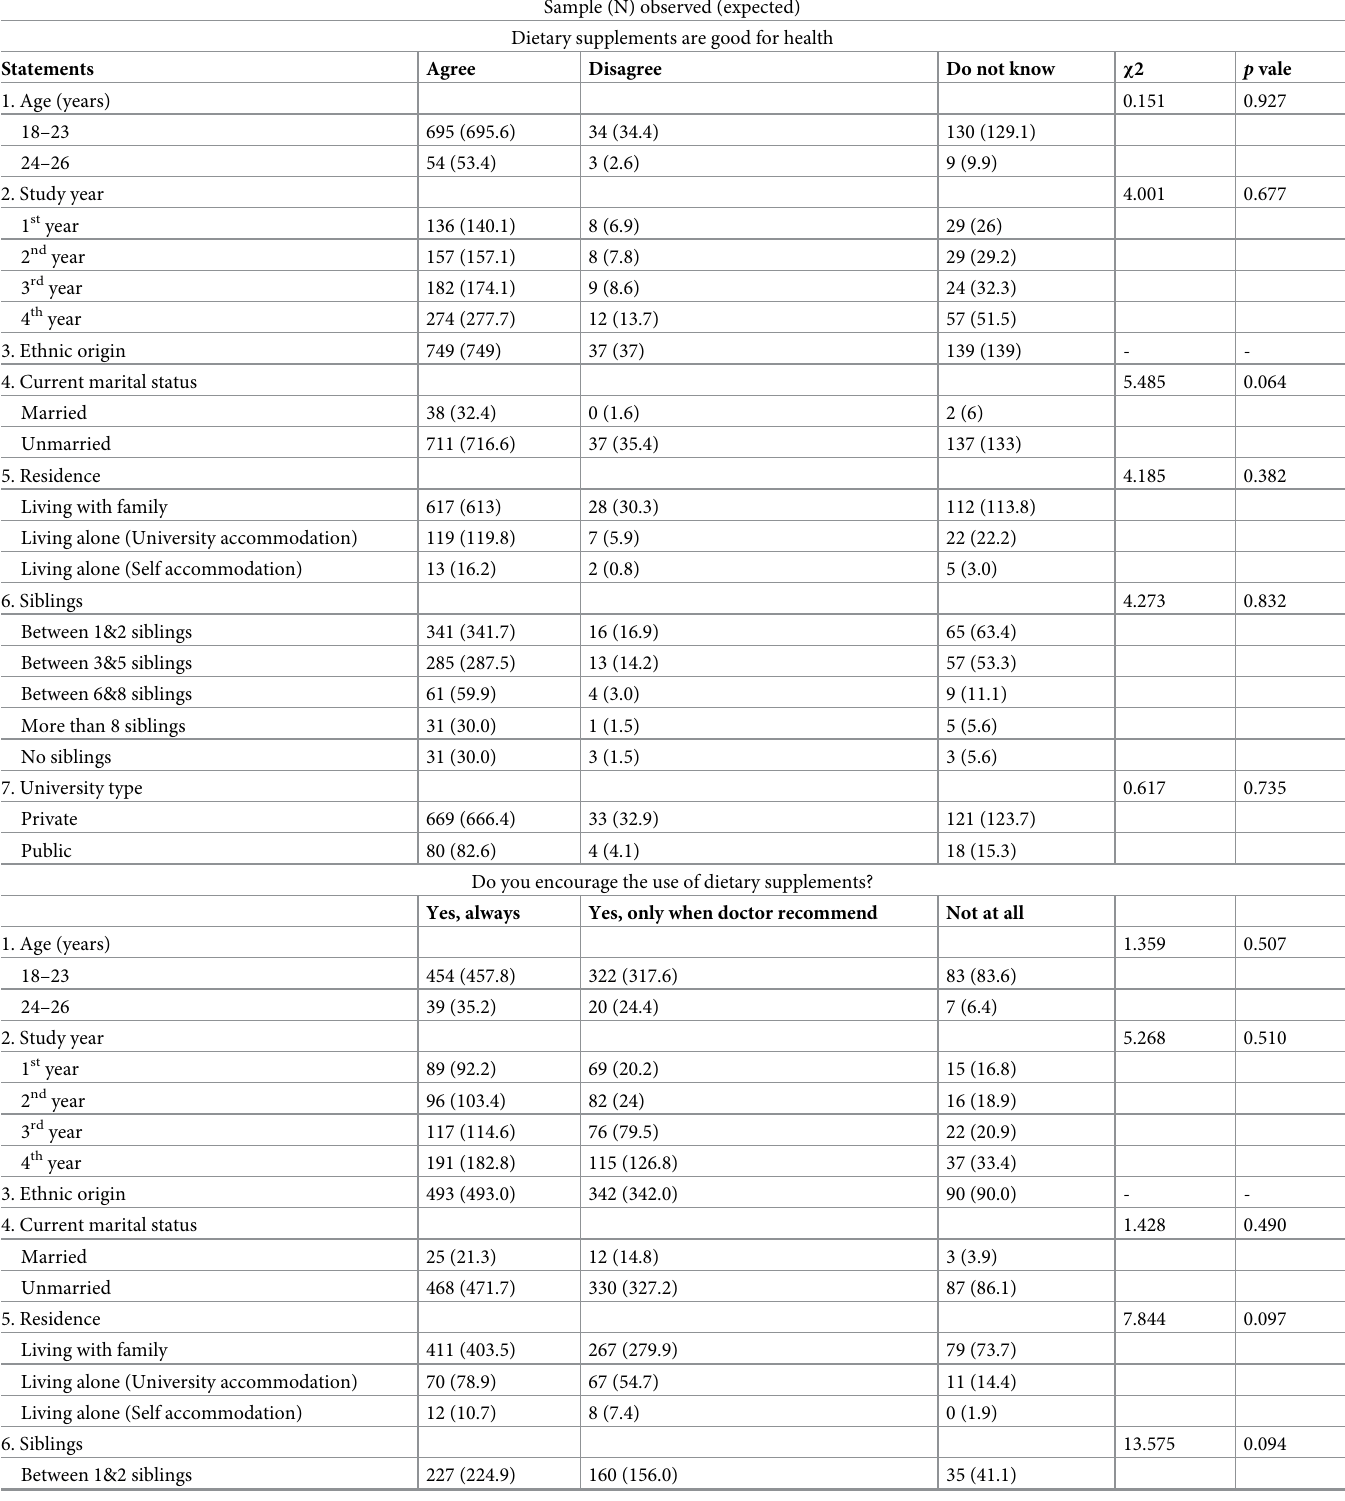
Table 11. Association of demographic variables with opinions and attitudes.